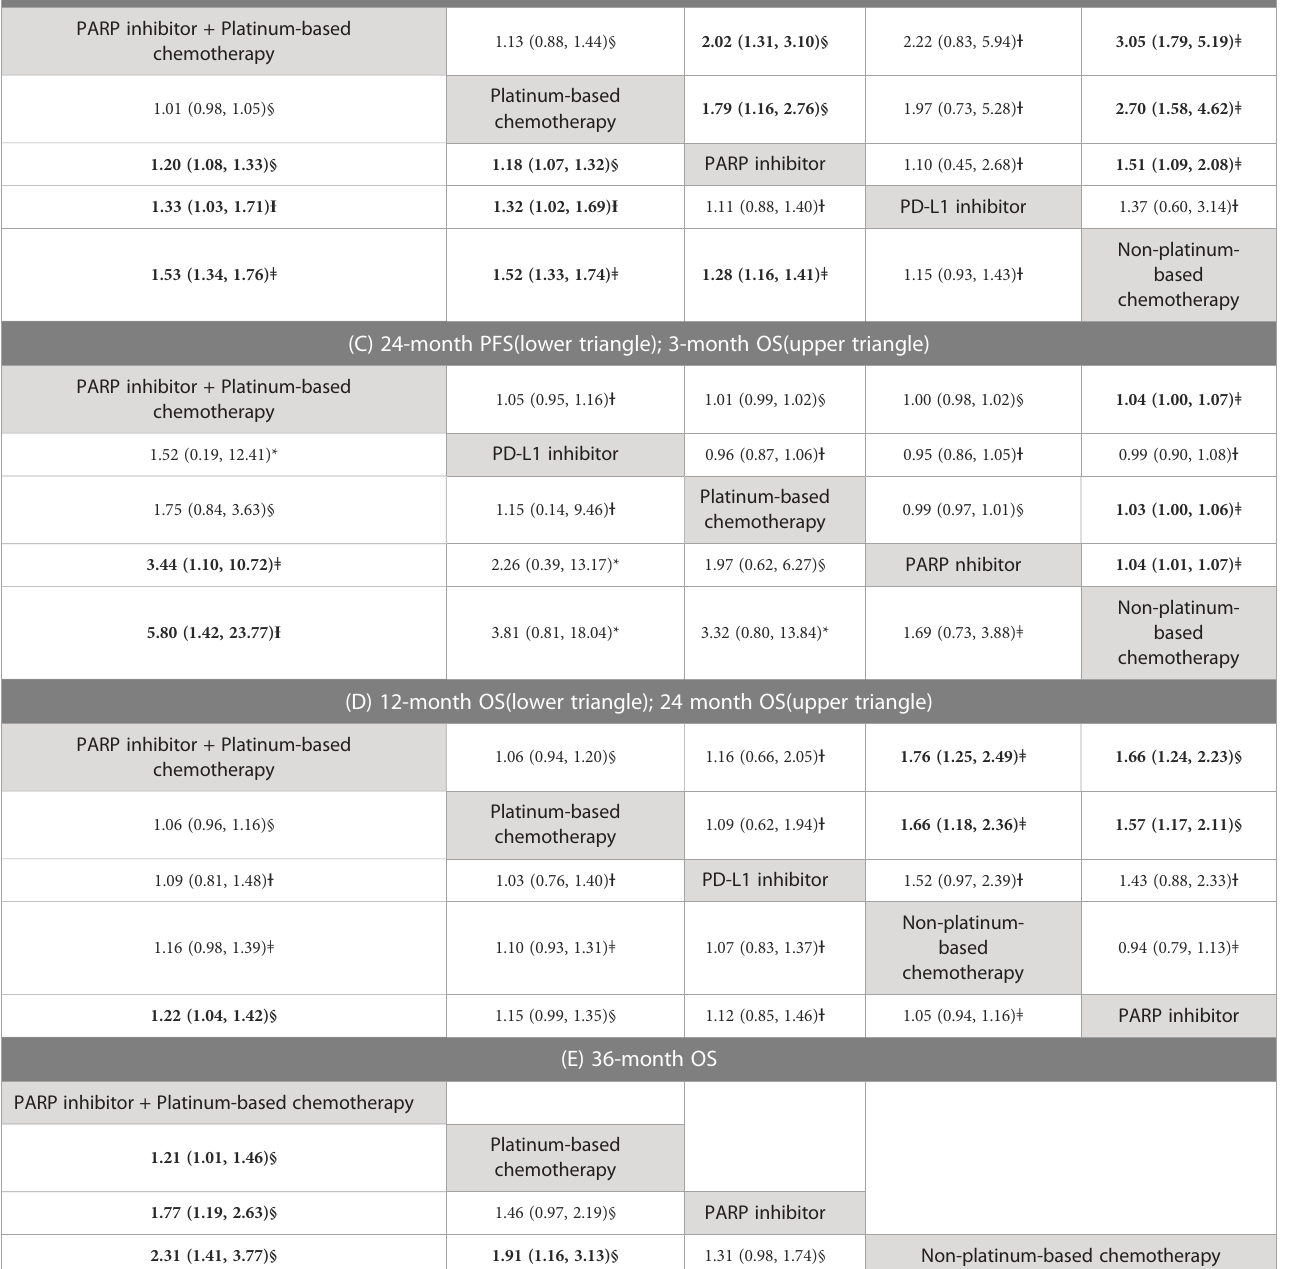
(B) 3-month PFS(lower triangle); 12-month PFS(upper